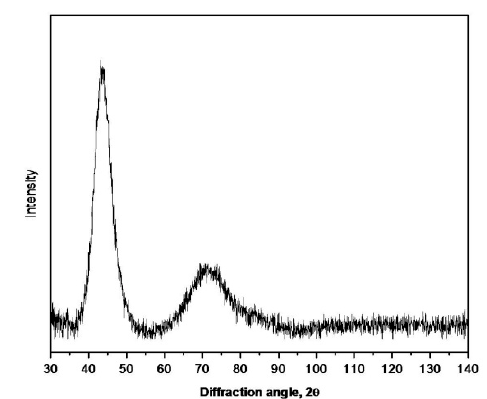
Figure 1. X-ray diffraction pattern of glassy Zr 55 Cu 30 Al 15 Ni 5 sample.